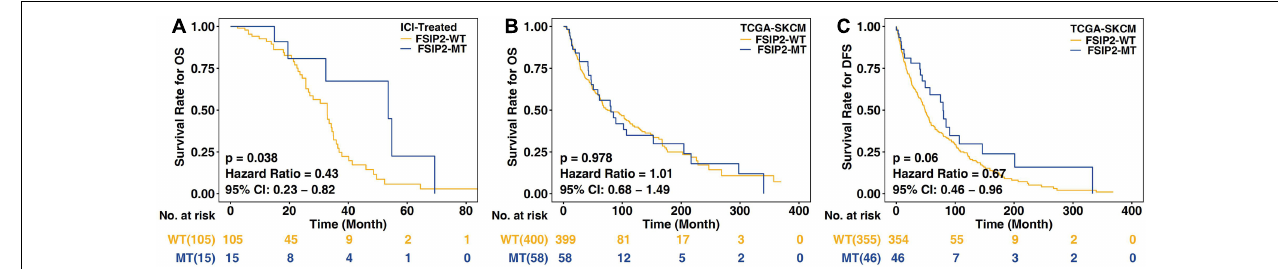
FIGURE 1 | Kaplan-Meier analysis of SKCM patients in the ICI-treated and TCGA-SKCM cohorts. The acquired cohorts were grouped according to the mutation status of FSIP2, with yellow indicating the FSIP2-WT group and blue indicating the FSIP2-MT group. (A) Kaplan-Meier curve of the overall survival (OS) of SKCM patients receiving ICIs. The overall survival of the FSIP2-MT group ( n = 15) was significantly longer than that of the FSIP2-WT group ( n = 105) [ p = 0.038; hazard ratio (95% CI): 0.43 (0.23–0.82)]. (B) Kaplan-Meier curve of the overall survival of SKCM patients in the collected TCGA-SKCM cohort. The FSIP2-MT group ( n = 58) and FSIP2-WT group ( n = 399) had no significant difference in overall survival [ p = 0.978; hazard ratio (95% CI): 1.01 (0.68–1.49)]. (C) Kaplan-Meier curve of the disease-free survival of SKCM patients in the collected TCGA-SKCM cohort. The FSIP2-MT group ( n = 58) and FSIP2-WT group ( n = 399) had no significant difference in overall survival [ p = 0.06; hazard ratio (95% CI): 0.67 (0.46–0.96)].